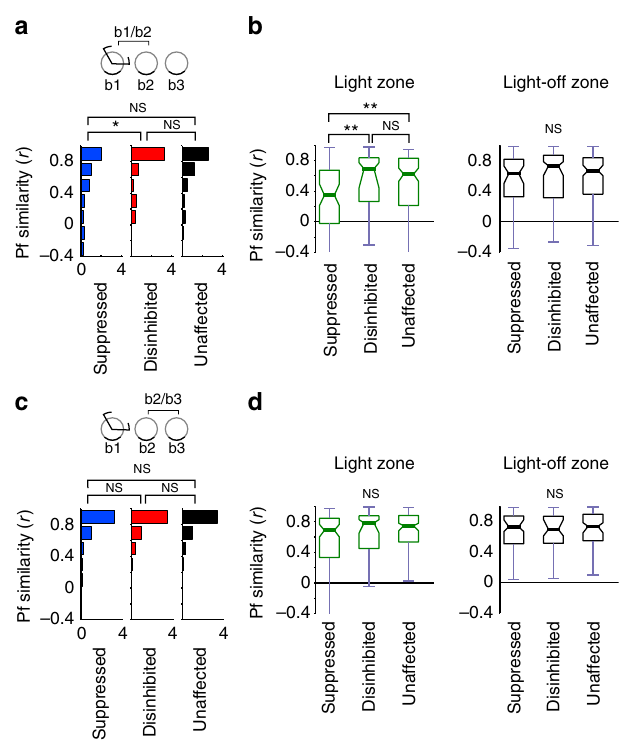
Figure 6 | PFSs of CA1 place cells between exploration sessions (novel paradigm). ( a ) Distribution of PFSs between the light-on session and the following exploration session using the entire arena. Kolmogorov–Smirnov test: suppressed–disinhibited: D ¼ 0.2760, * P B1|3 ¼ 0.0173; suppressed– unaffected: D ¼ 0.1936, P B2|3 ¼ 0.0929; disinhibited–unaffected: D ¼ 0.1461, P B3|3 ¼ 0.3396. ( b ) Boxplots showing PFSs for comparison in a separately for light zone (green) and outside (black). Boxes extend from lower to upper quartile values of the data, thick line and notch indicate median with 95% confidence interval. Whiskers show the range of the data. Left: Kruskal–Wallis test: H ¼ 13.56, ** P ¼ 0.0011, post hoc Mann–Whitney test: suppressed–disinhibited: U ¼ 1916.0, ** P B1|3 ¼ 0.0037; suppressed– unaffected: U ¼ 3490.5, ** P B2|3 o 0.0038; disinhibited–unaffeted: U ¼ 3224.0, P B3|3 ¼ 0.6376. Right: Kruskal–Wallis test: H ¼ 1.87, P ¼ 0.3934. ( c ) Comparison between b2 and b3 using entire arena. Kolmogorov–Smirnov test: suppressed–disinhibited: D ¼ 0.1436, P B2|3 ¼ 0.8139; suppressed–unaffected: D ¼ 1786, P B1|3 ¼ 0.2438; disinhibited–unaffected: D ¼ 0.1078, P B3|3 ¼ 0.77213. ( d ) Same as in b but comparing sessions b2 and b3. Left: Kruskal–Wallis test: H ¼ 3.24, P ¼ 0.1979. Right: Kruskal–Wallis test: H ¼ 0.36, P ¼ 0.8351. * P o 0.05, ** P o 0.01, *** P o 0.001. NS, not significant.